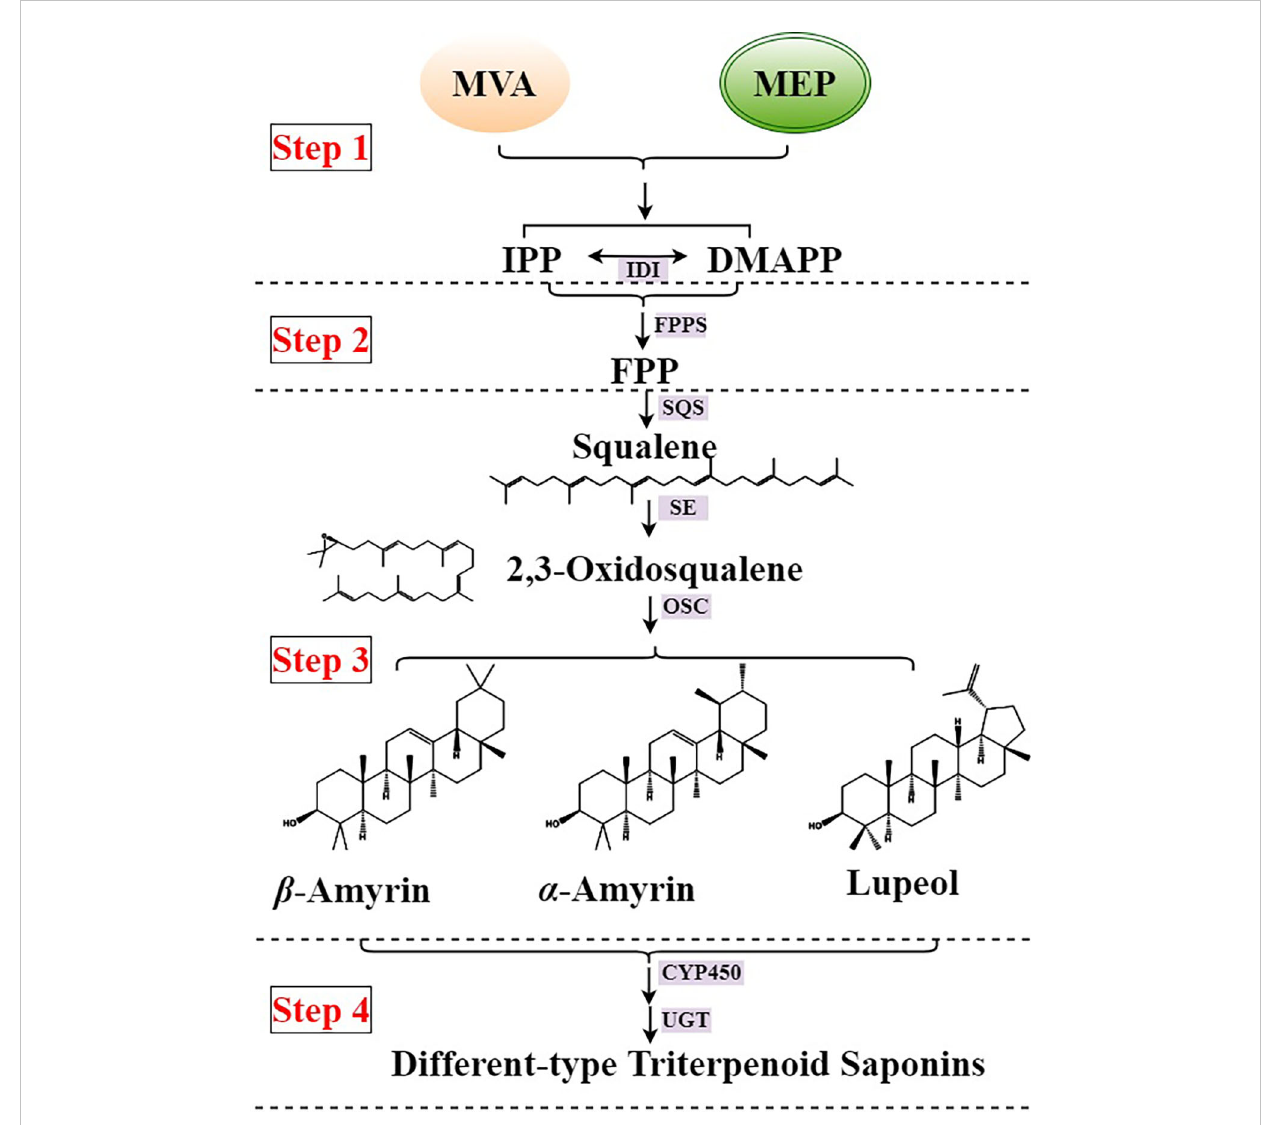
FIGURE 1 Biosynthesis of triterpenoid saponins in plants. IDI, IPP/DMAPP isomerase; FPPF, farnesyl pyrophosphate synthase; SQS, squalene synthase; SE, squalene epoxidase; OSC, oxidosqualene cyclases; CYP450, cytochromes P450; UGT, UDP-dependent